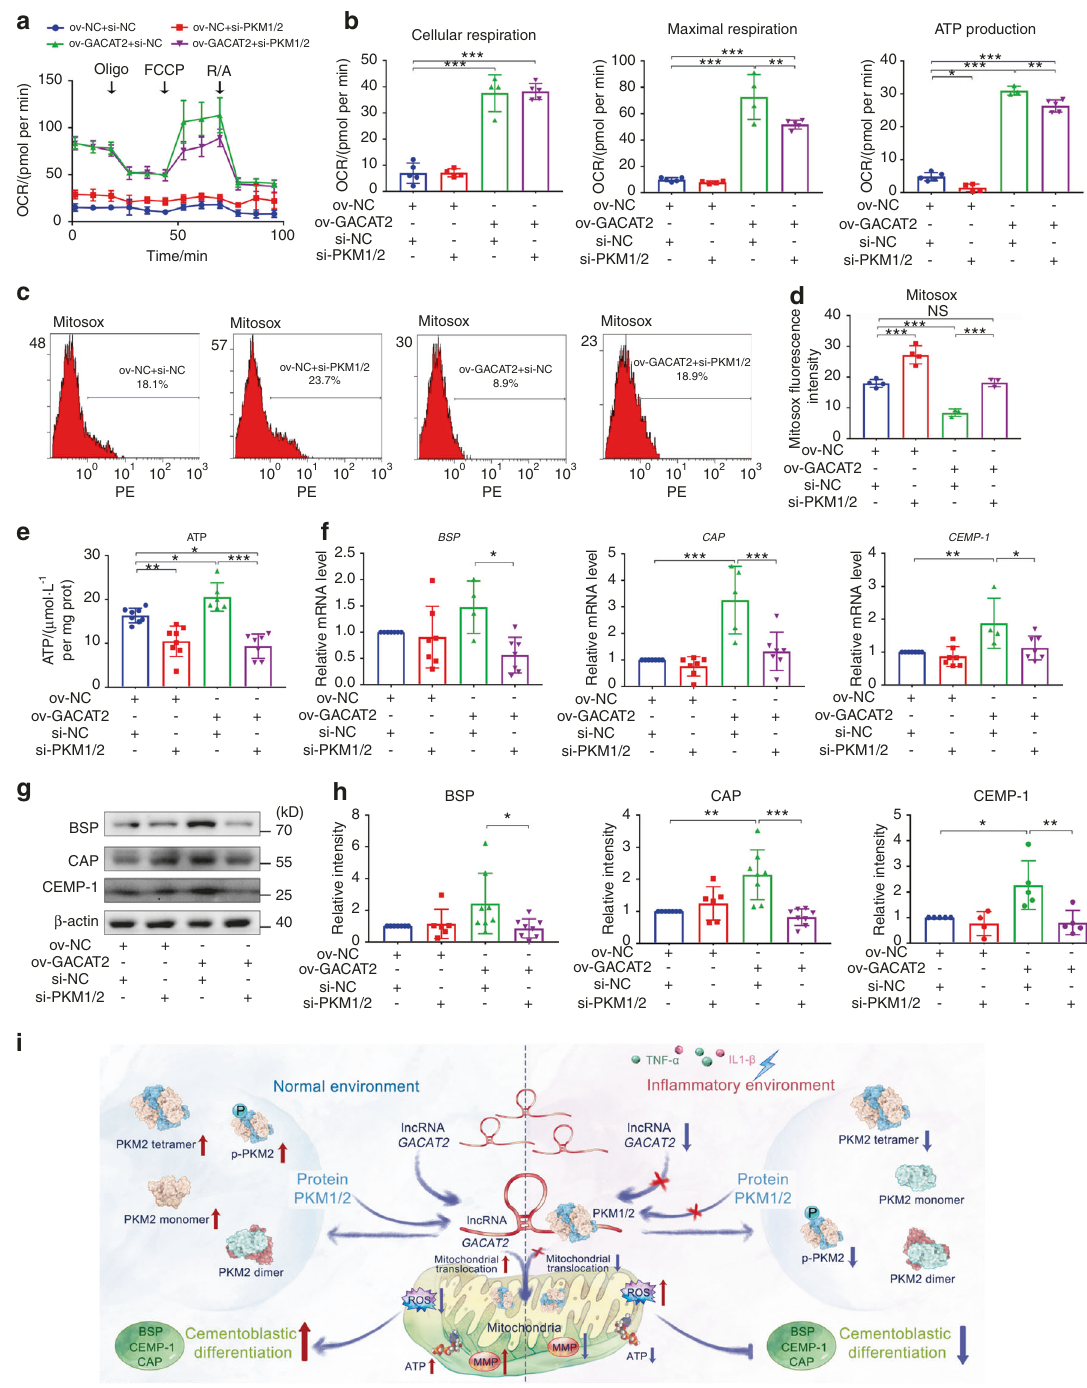
Fig. 8 Inhibition of PKM1/2 impairs GACAT2 overexpression-rescued mitochondrial function and cementoblastic differentiation of PDLSCs. The cells were transfected with ov-NC or ov- GACAT2 and incubated in medium with both in fl ammatory cytokines and EMD (in fl ammatory environment), and both ov-NC- and GACAT2 -transfected cells were then further transfected with si-NC or si-PKM1/2. a OCR of PDLSCs determined by a Seahorse Bioscience XFAnalyzer; arrows indicate the sequential injection of 1 μ mol·L − 1 Oligo, 1 μ mol·L − 1 FCCP and 2 μ mol·L − 1 R/A. b Quanti fi cation of cellular respiration (basic OCR value prior to Oligo injection), maximal respiration (differences between the maximum rate measurement after FCCP injection and the minimum rate measurement after R/A injection) and ATP production (difference between the fi nal rate measurement prior to Oligo injection and the minimum rate measurement after Oligo injection) of PDLSCs. c mtROS levels in PDLSCs determined with the aid of a MitoSOX probe ( fl ow cytometric analysis). d Quanti fi cation of mtROS levels (re fl ected by the relative fl uorescence intensity of MitoSOX). e Intracellular ATP contents (ATP assay). f Relative cementoblastic differentiation-related gene expression levels of BSP , CAP and CEMP-1 determined by qRT-PCR. g Relative cementoblastic differentiation-related protein expression of BSP, CAP and CEMP-1 determined by western blots. h Semiquantitative analysis of protein expression levels (normalized to β -actin) in terms of the relative gray density. i The diagram shows that the lncRNA GACAT2 plays a central role in regulating mitochondrial function and cementoblastic differentiation of PDLSCs in an in fl ammatory environment. Mechanistically, it functions by binding to PKM1/2 proteins to modulate cell mitochondrial bioenergetics and/or metabolism. The data are shown as the mean ±SD for n from 3 to 8; * P <0.05, ** P <0.01 and *** P <0.001 indicate signi fi cant differences between the indicated